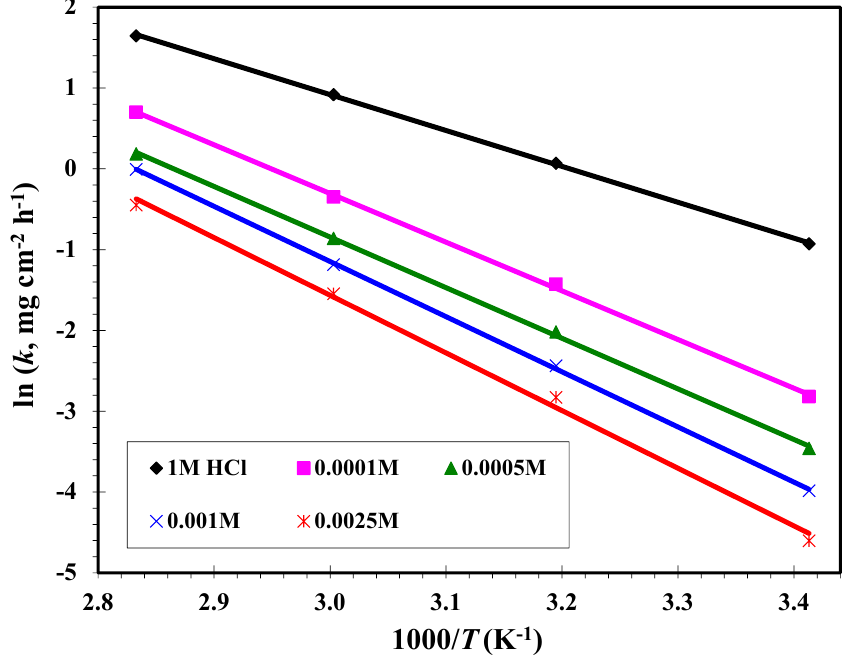
Figure 21. ln k versus 1 / T curves for MS dissolution in the absence and presence of di ff erent concentrations of CGSES14 in 1 M HCl solution.